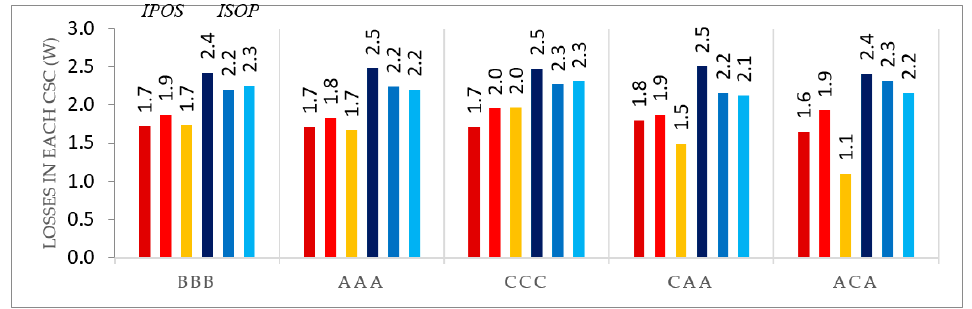
Figure 13. Losses in CSCs depending on association at operating point N ◦ 2 in IPOS and ISOP.